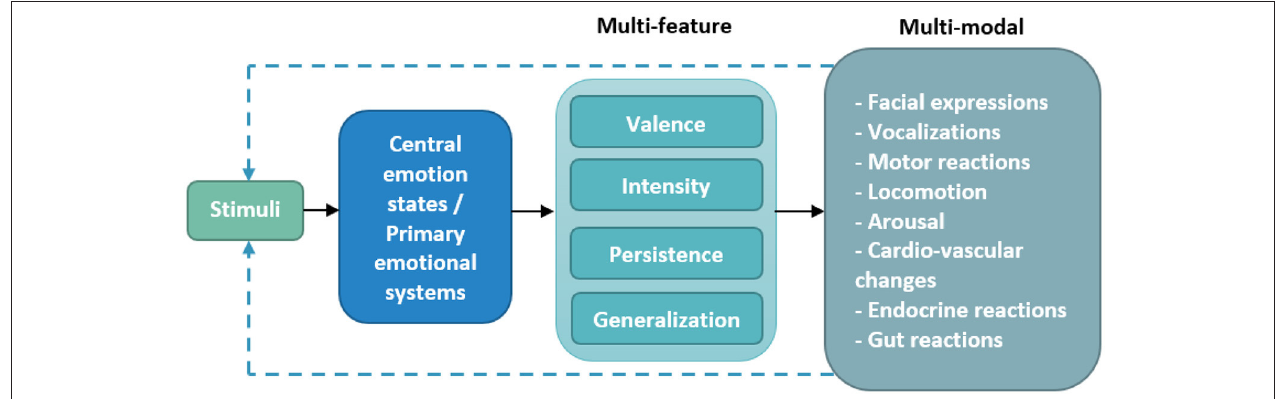
FIGURE 1 | Expression of emotions across